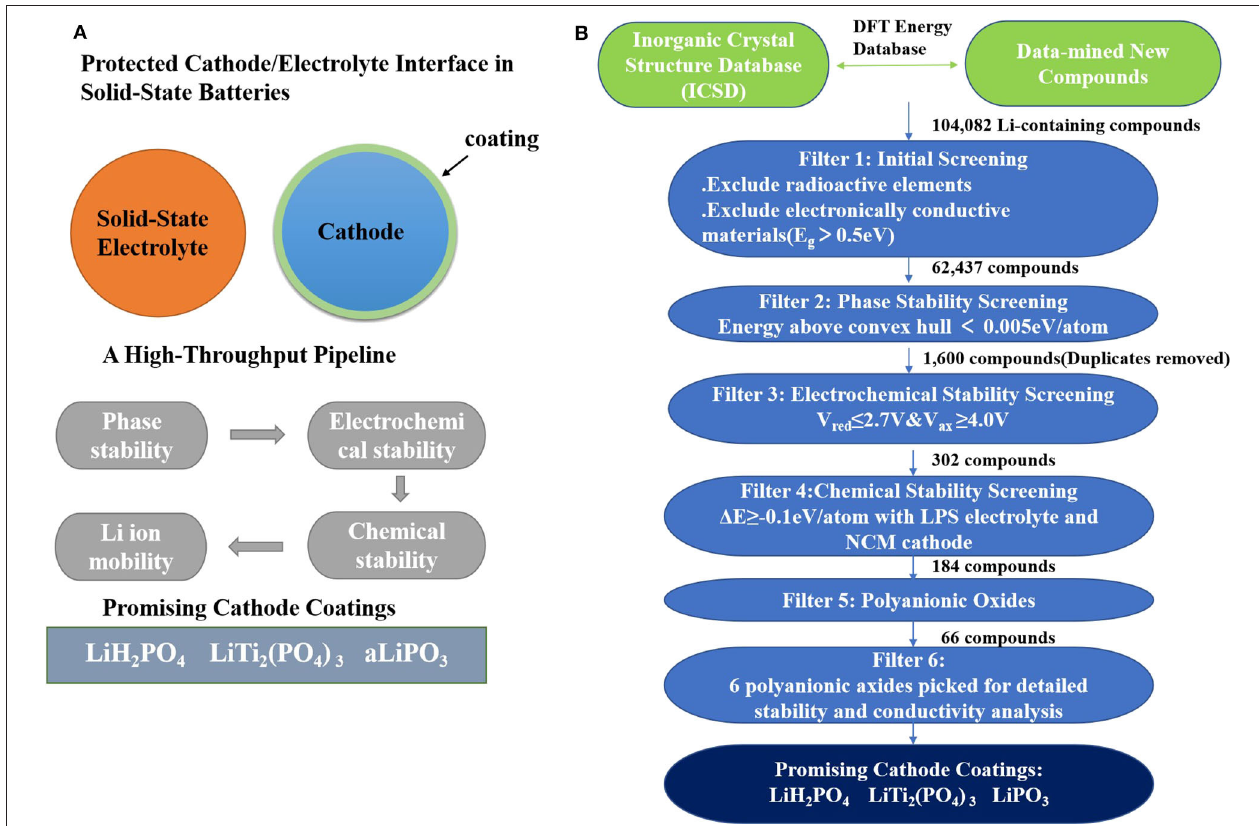
FIGURE 5 | (A) The computational screening schematic diagram of cathode coatings. (B) A flow diagram describes the computational screening of cathode-coating materials.